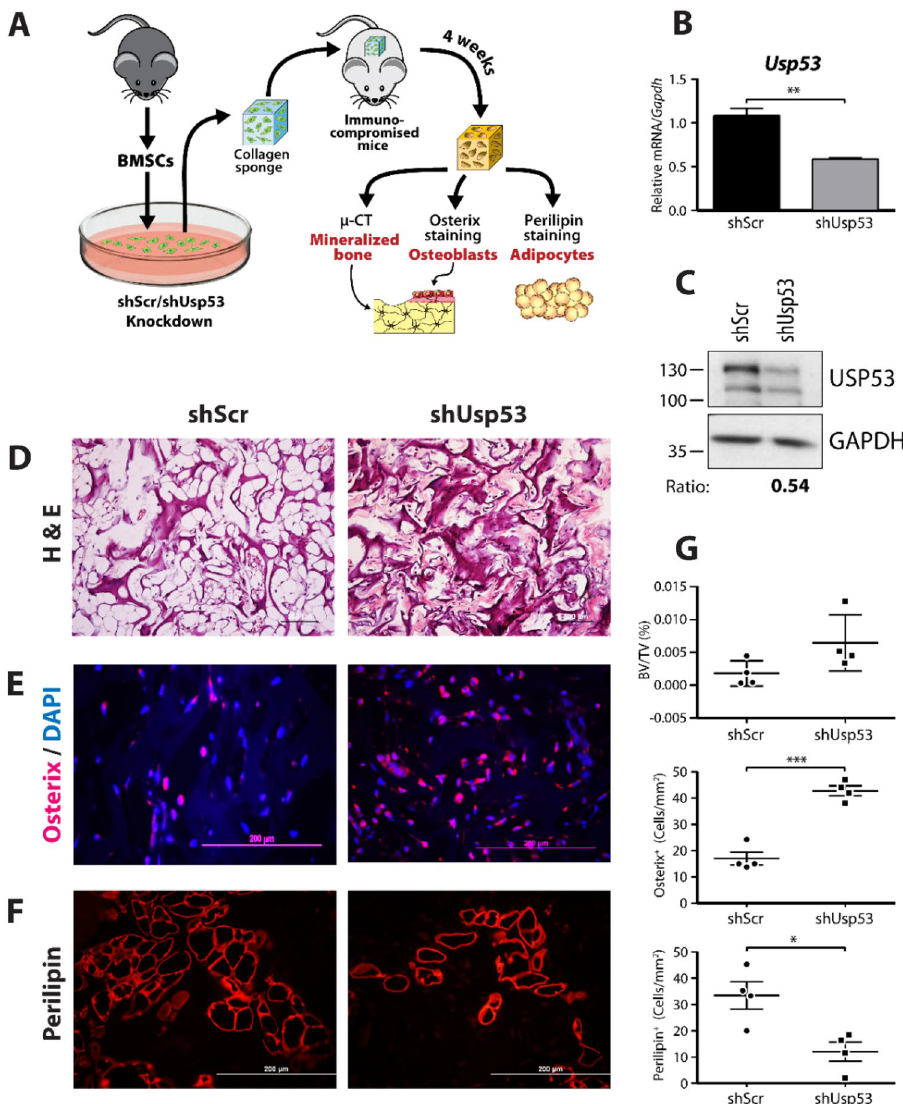
Figure 8. Usp53 knockdown enhances osteoblastogenesis and inhibits adipogenesis in vivo . ( A ) Scheme showing the workflow of the in vivo osteogenesis assay performed on immunocompromised mice. The mouse drawing is based on a free download from flyclipart.com which was adapted for our purposes. The software used to create the diagram was Adobe Illustrator CS5 (https:// www. adobe. com/ ca/ produ cts/ illus trator. html) ( B ) Knockdown of Usp53 in bone marrow stromal cells (BMSCs). Quantitative RT-qPCR using TaqMan probe against Usp53 , normalized to Gapdh , was performed on RNA isolated from stable BMSCs cultures transfected with shScr or shUsp53. ( C ) Immunoblot of whole cells extracts from BMSCs stably expressing shRNA targeting Usp53 (shUsp53) and scrambled shRNA (shScr) as control. Membranes were probed with anti-USP53 and anti-GAPDH antibodies (as loading controls). Relative signal intensity quantified using ImageJ is shown below. Full-length blots are presented in Supplementary Figure S8. ( D ) H & E staining of murine implants (shScr and shUsp53) after 4-weeks of BMSCs transplantation embedded in collagen sponge. ( E ) Immunostaining of the implants (shScr and shUsp53) showing Osterix staining for osteoblasts (red) and DAPI staining for nuclei (blue). ( F ) Immunostaining of the implants (shScr and shUsp53) showing Perilipin staining for adipocytes (red). (G) Quantification of the newly formed bone in the implants using Micro-CT (upper panel); quantification of Osterix-positive osteoblast cells (middle panel); quantification of perilipin-positive adipocytes (lower panel). BV/TV, bone volume/tissue volume. * P < 0.05, ** P < 0.01, ***P < 0.001; t test was used as statistical test in all